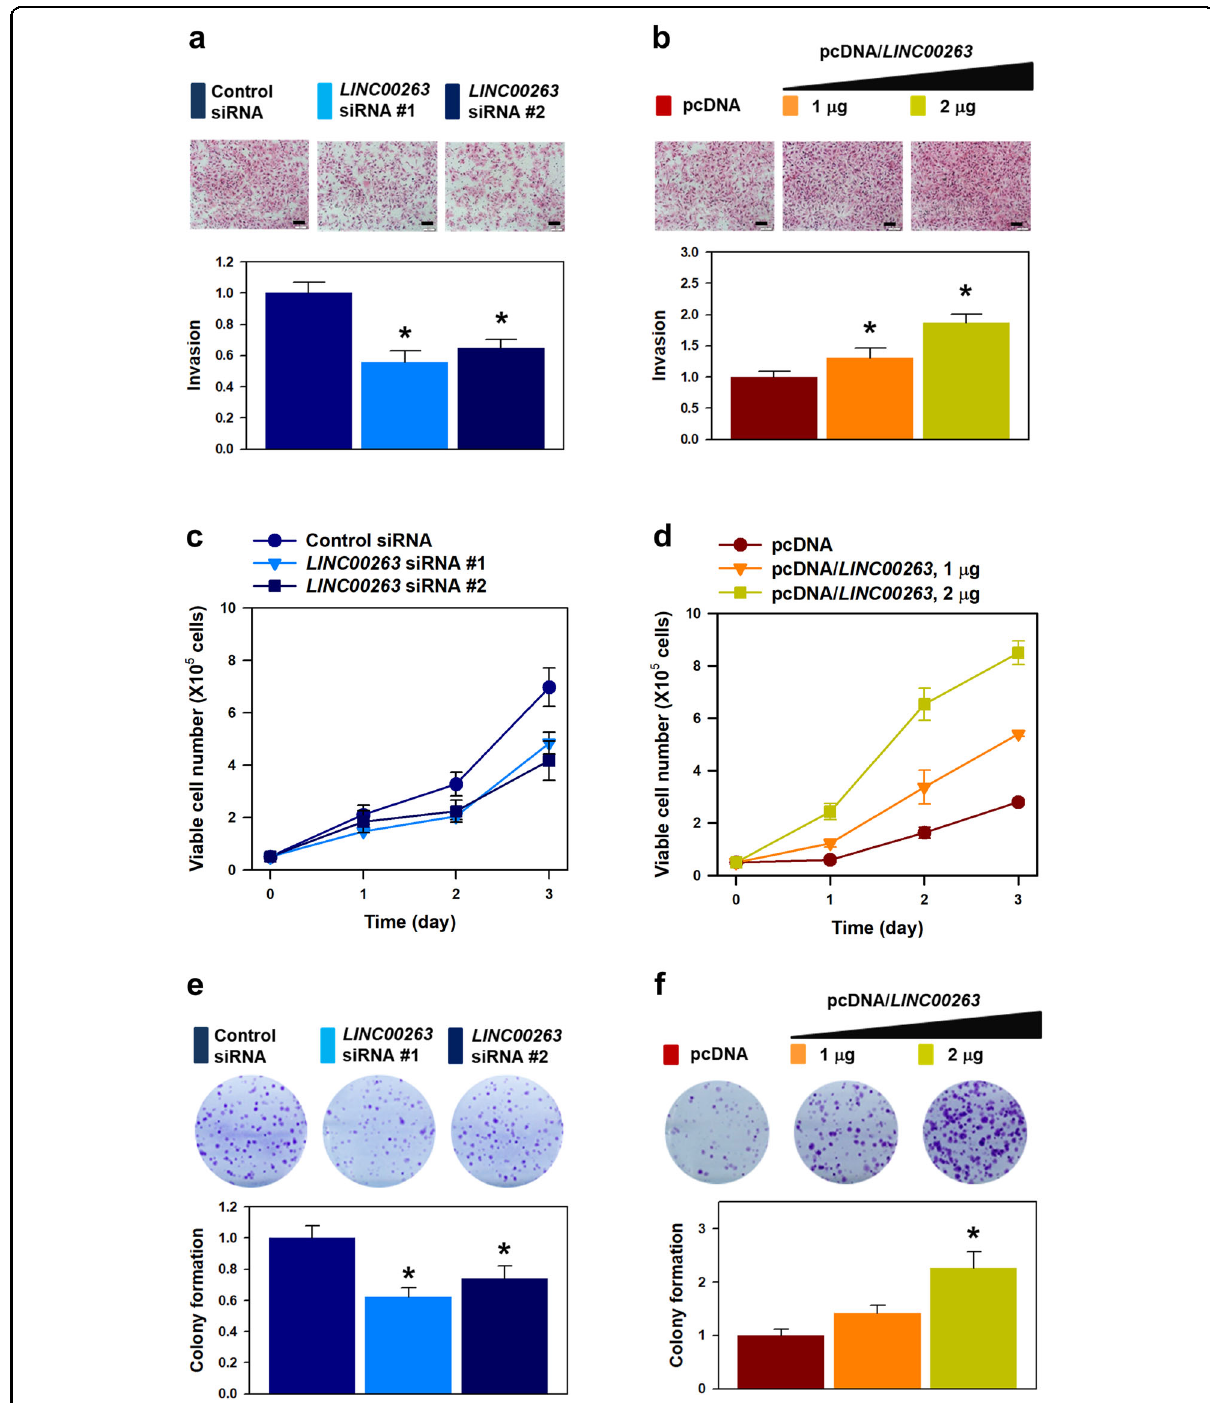
Fig. 3 LINC00263 regulates the malignant phenotypes. To investigate whether LINC00263 is required for hnRNPK-mediated malignant phenotypes, two independent siRNAs ( a , c , and e ) and overexpression vector (pcDNA/ LINC00263 : b , d , and f ) were used. Invasiveness was determined using Transwell invasion assay ( a , b ). Cellular proliferation ( c , d ) and clonogenicity ( e , f ) were assessed by counting the number of viable cells and colonies, respectively, as described in “ Materials and methods ” . Bars on microscopic images represent 100 μ m. Statistical analyses were performed using the Student ’ s t test using three independent experiments (* p < 0.05). All data represent mean ± standard variation